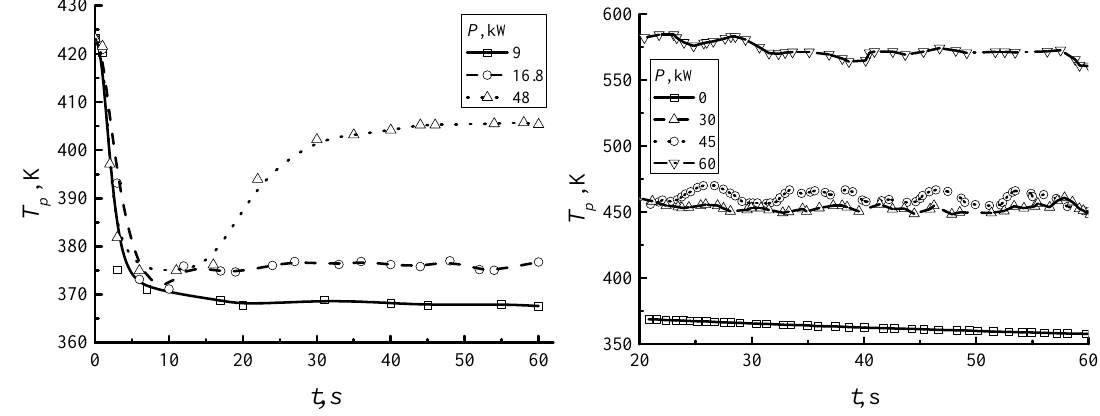
Figure 6. Variations of the molten alloy temperature at different P for trial A ( left ) and trial B ( right